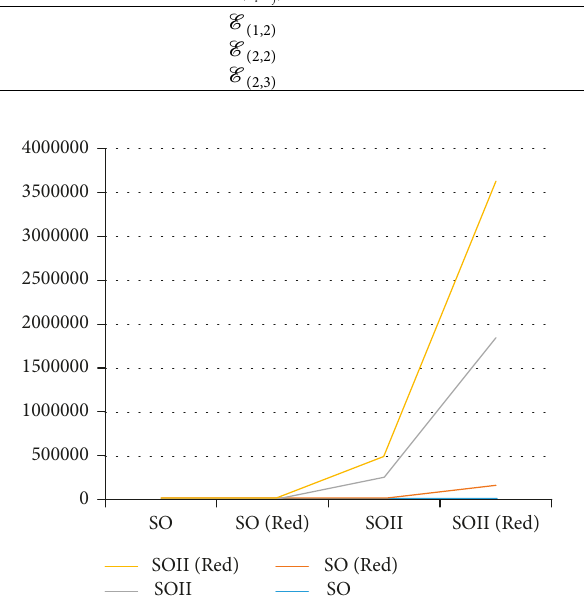
Figure 9: Graphical comparison of SO , SO